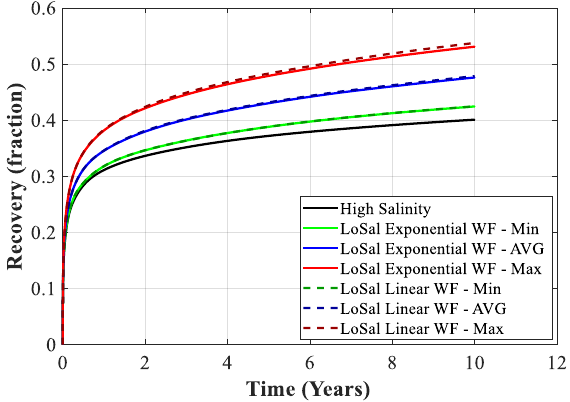
Figure 8. Oil recoveries of the fine-scale model using an exponential weighting factor and a single- porosity model for various levels of relative permeability alterations (minimum, average, and maximum), in addition to the high salinity waterflooding scenario. Meanwhile, the same scenarios were repeated using a linear weighting factor, as indicated by dashed lines.